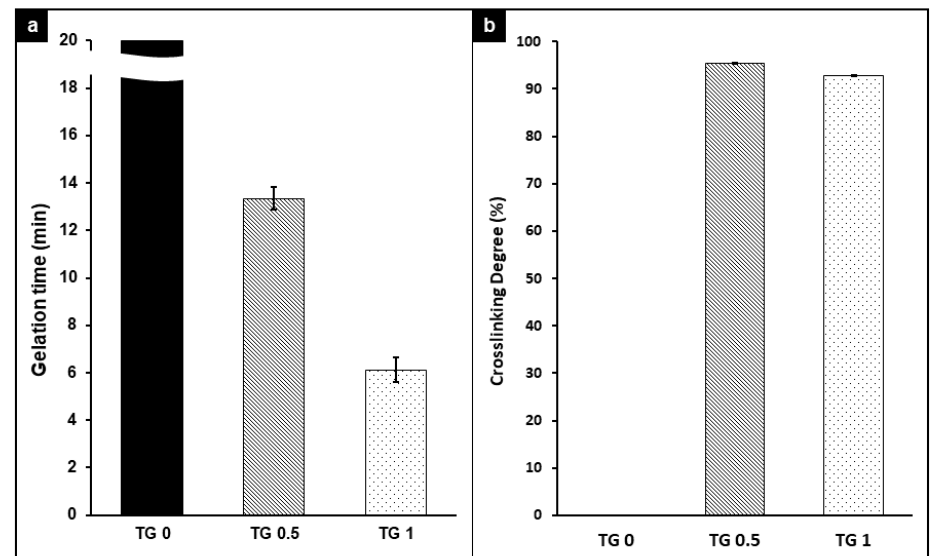
Figure 3. Gelation time ( a ) and degree of crosslink ( b ) between hydrogel with 3 different concen- trations of transglutaminase (TGase) added. The gelation time decreased as TGase concentration increased, and the presence of TGase achieved over 90% crosslink for both 0.5% and 1.0%. Figure 4 showed a visual representation of the surface and degree of crosslink of hydrogel under an electron microscope. As shown, the surface became rougher and the cross section showed denser linkage as TGase concentration increased.